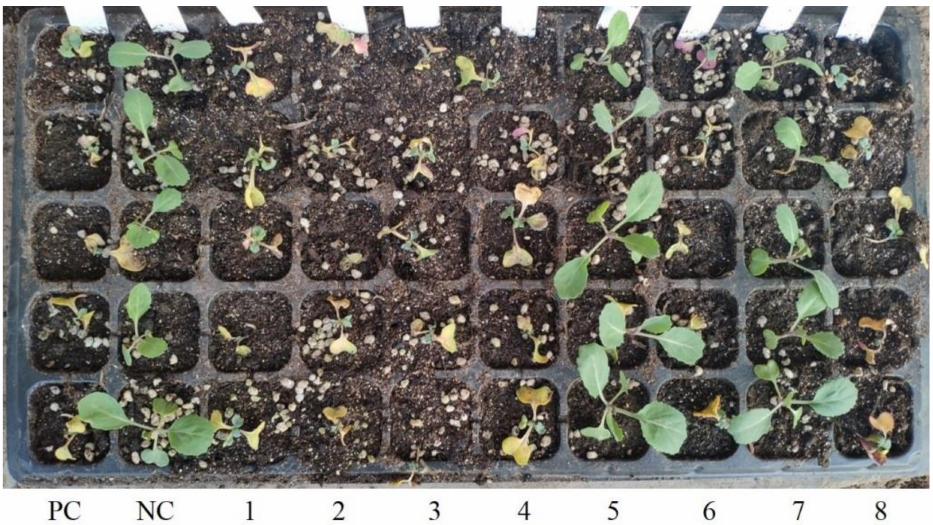
Figure 5. Phenotyping and test crossing results. PC, positive control group: hybrid lethality F 1 (09-211 × 09-222); NC, negative control group: normal cross combination 09-211 × 87-534; 1, 2, 3, 4, 6 and 8 exhibited the same lethal phenotype with 100% seedling mortality; 5 and 7 appeared